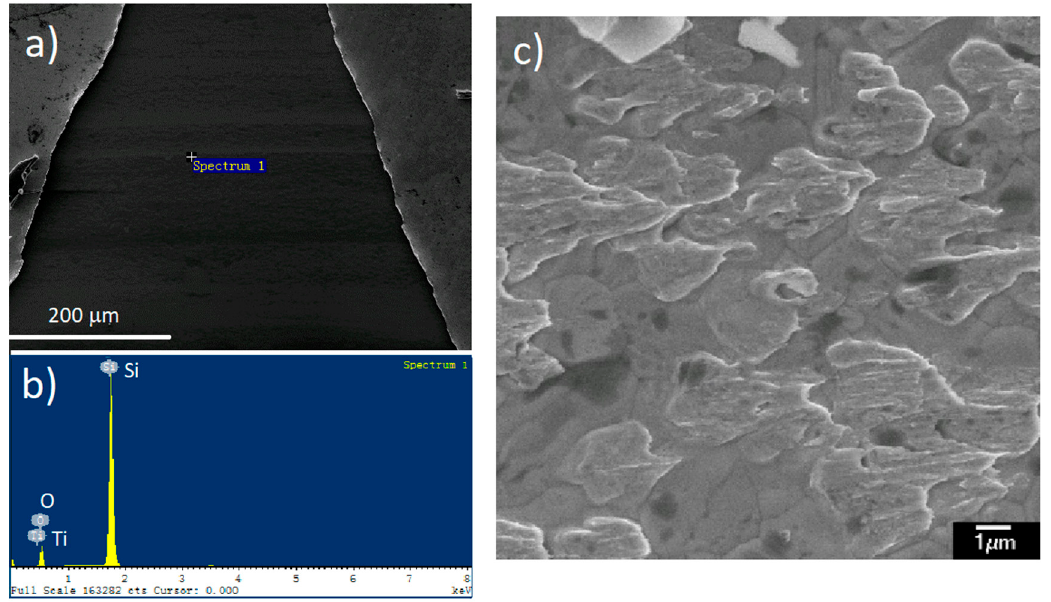
Figure 9. ( a , b ) EDAX results of separated surface, showing exposed silicon oxide below after shear test; ( c ) Plan-view SEM image of stretched grains on fractured surface.